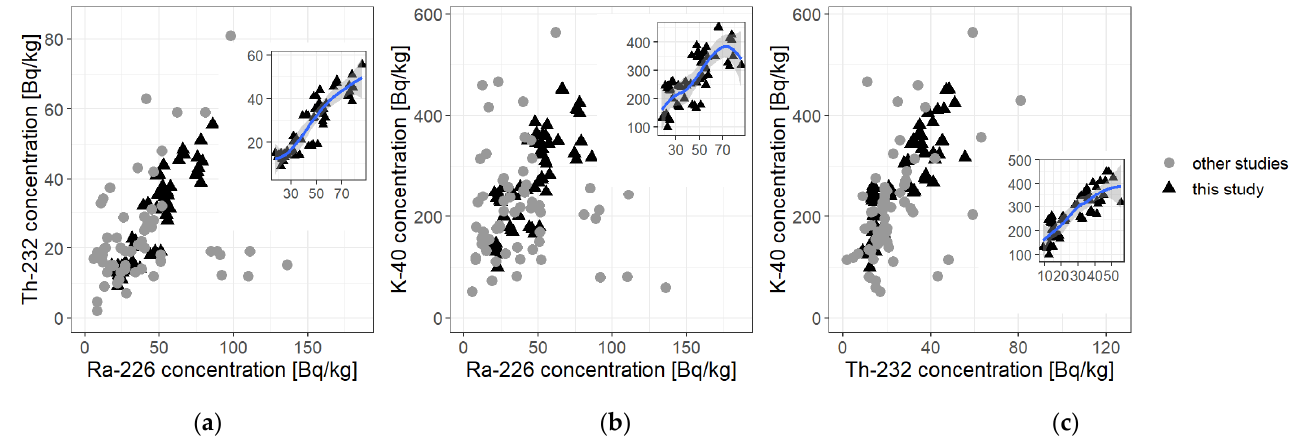
Figure 5. Diagram of dependencies of the concentration activity of thorium 232 Th on radium 226 Ra ( a ), potassium 40 K on radium 226 Ra ( b ), and potassium 40 K on thorium 232 Th ( c ). Quite strong correlation is clearly visible on all of the plots; however, the strongest one is for Ra-Th dependence. A linear dependence with a narrow confidence corridor at the level of 99% is only noticeable in the pair of Ra-Th for data obtained by the authors, and a considerable dispersion of values and a wide confidence corridor are noticeable in two remaining cases, and prove a weak dependence in the correlation, though it still remains positive.